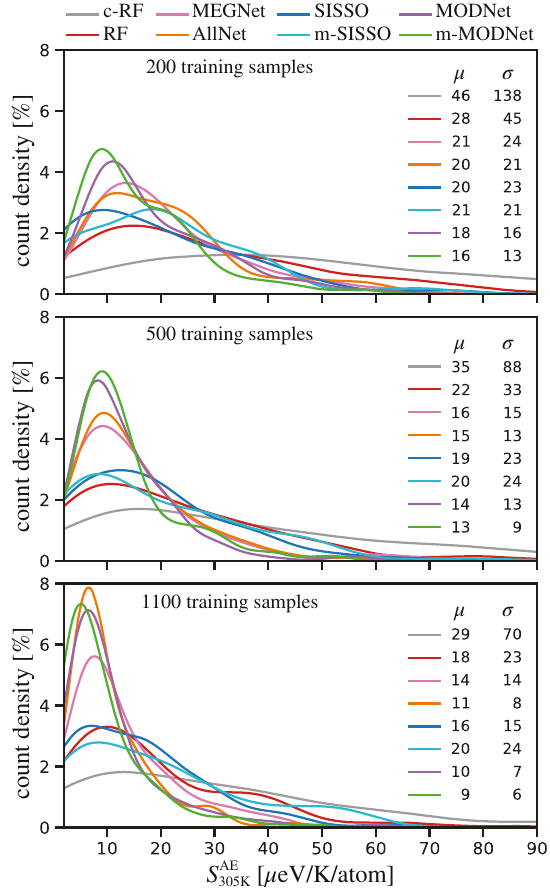
Fig. 2 Comparison of the test error distributions on the vibrational entropy for different models. Absolute error distribu- tion on the vibrational entropy at 305 K ( S 305 K in μ eV/K/atom) at three training sizes and for various strategies (see text for a detailed description). The density is obtained from a kernel density estimation with Gaussian kernel. The mean μ (equal to the MAE) and variance σ of each distribution are also reported in μ